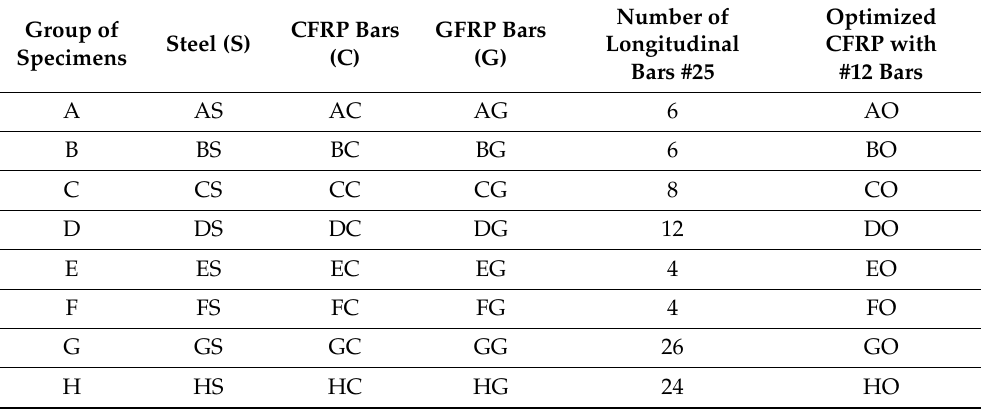
Table 4. Model’s